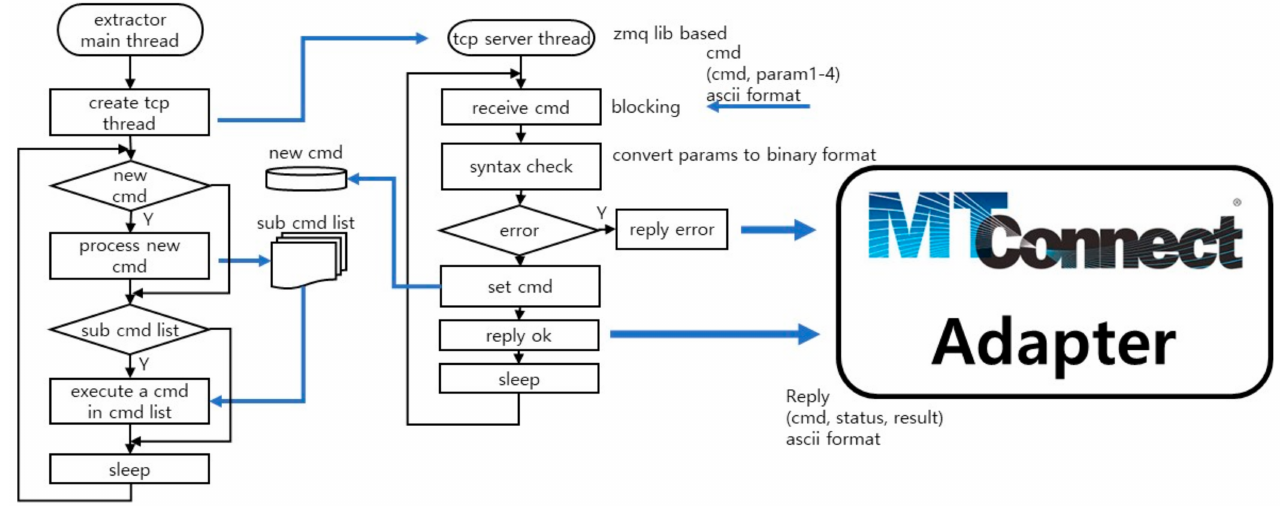
Figure 4. DNA extraction process command (cmd) with parameter (param) flow